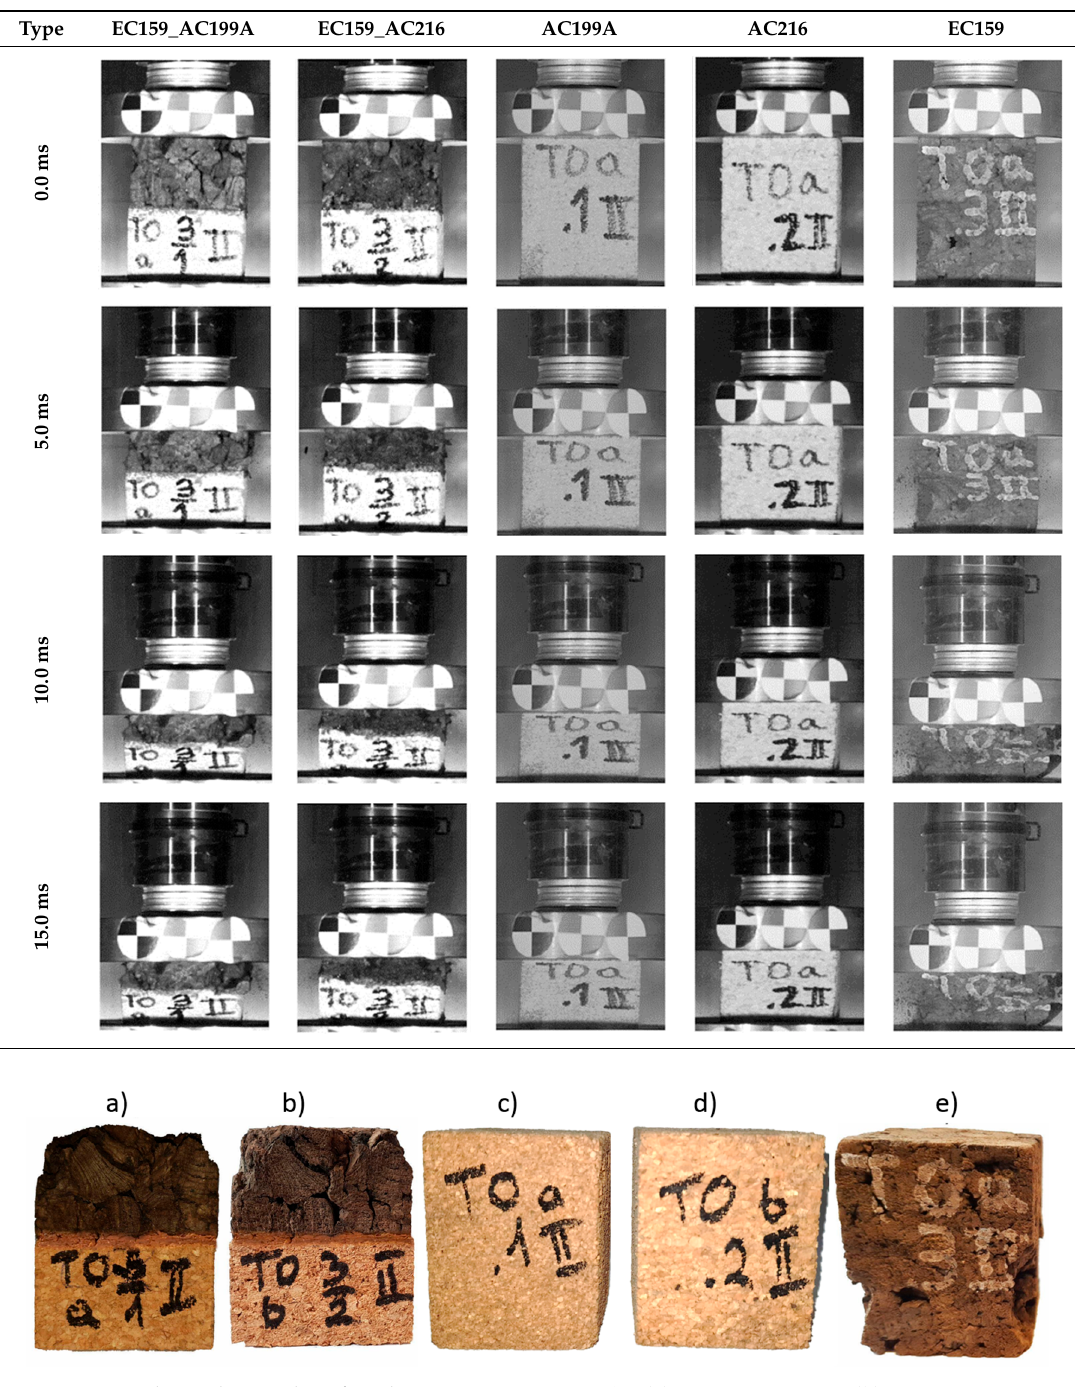
Figure 2. The cork samples after the 100 J impact at 24 ◦ C ( a ) EC159_AC199A, ( b ) EC159_AC216, ( c ) AC199A, ( d ) AC216, ( e ) EC159.